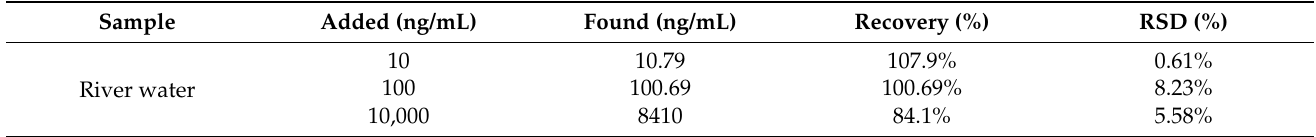
Table 1. Analytes detected in real samples (n = 3).